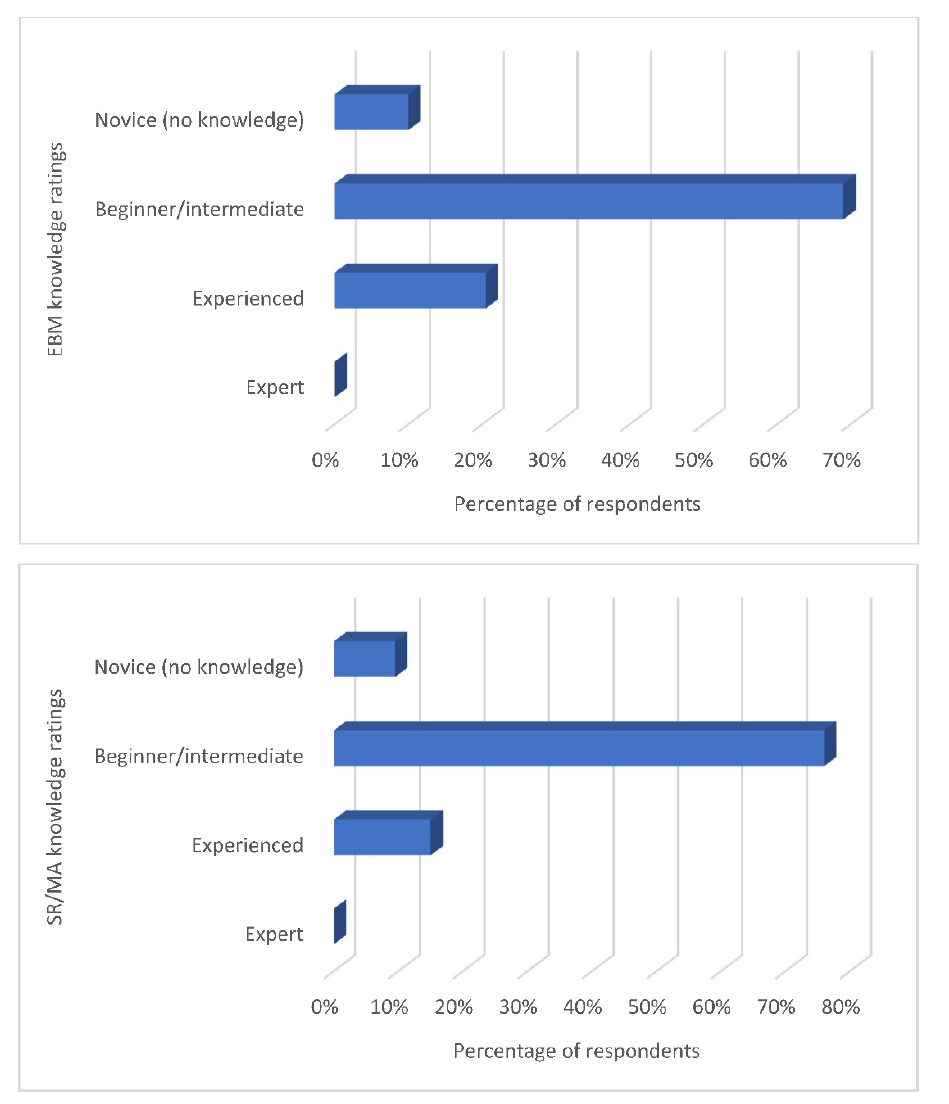
Figure 4 Nigerian medical librarians’ knowledge of evidence-based medicine (EBM) (top) and systematic reviews (SR)/meta-analyses (MA)